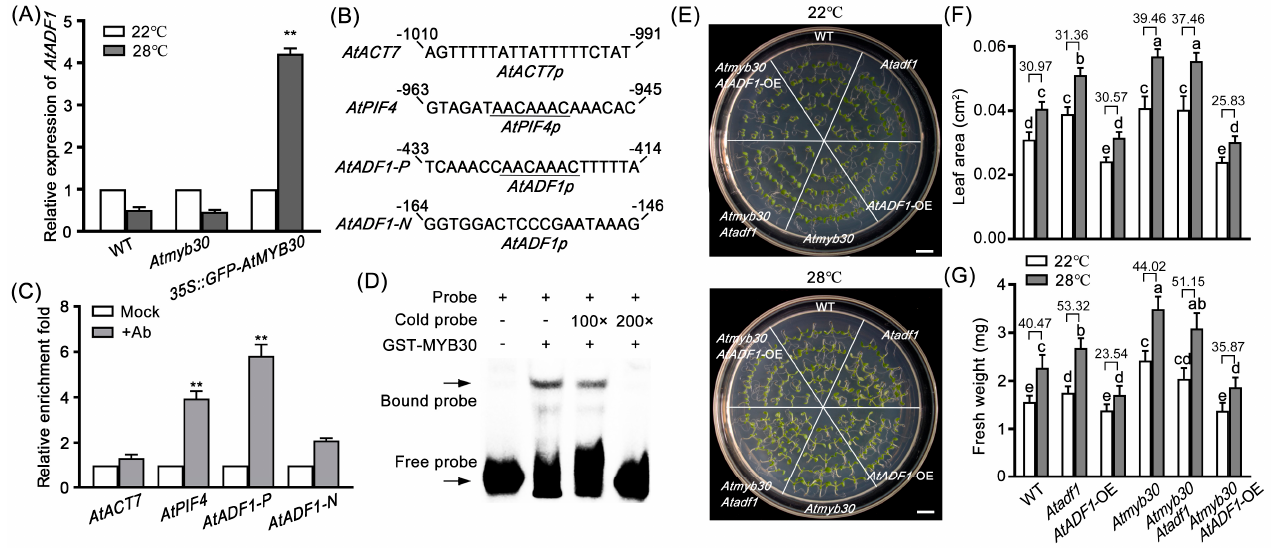
Figure 3. AtMYB30 directly binds to the AtADF1 promoter and positively regulates the expression of AtADF1 under high temperature. ( A ) The relative expression of AtADF1 in 3 − day − old WT, Atmyb30, and AtMYB30 OE seedlings treated with 28 ◦ C for 4 d was determined by RT-qPCR. Data show mean values ± SD from three independent replicates (Student’s t -test, ** p < 0.05). ( B ) MYB − binding site AACAAAC in the AtADF1 promoter. ( C ) ChIP − qPCR analysis indicates that AtMYB30 is associated with the AtADF1 promoter in vivo. AtADF1 − N and AtACT7 are as negative controls, and AtPIF4 is as a positive control. Data show mean values ± SD from three independent replicates. (Student’s t -test, ** p < 0.01). ( D ) EMSA assay of the interaction between AtMYB30 and AtADF1 promoter. The arrow indicates the bands resulting from GST − MYB30 binding to AtADF1 promoter P. ( E ) The thermal adaptation of WT, Atadf1 , AtADF1 − OE, Atmyb30 , Atmyb30 Atadf1 − 1, and Atmyb30 AtADF1 − OE seedlings was visualized. Three − day − old seedlings of WT, Atadf1 , AtADF1 − OE, Atmyb30 , Atmyb30 Atadf1, and Atmyb30 AtADF1 − OE were transferred into a 28 ◦ C chamber for four days. Scale bar = 1 cm. ( F , G ) Leaf area and fresh weight of WT, Atadf1 , AtADF1 − OE, Atmyb30 , Atmyb30 Atadf1 and Atmyb30 AtADF1 − OE seedlings at normal (22 ◦ C) and high temperature (28 ◦ C). The number in the columns is the percentage increase between normal and high temperature conditions. At least 60 leaves from 30 seedlings were examined for leaf area, and at least 300 seedlings were examined for fresh weight, per genotype and treatment. Values are mean ± SD from three independent replicates. All of the statistical analyses use a one-way ANOVA followed by a Tukey’s post-hoc test. Significant differences were indicated by different lowercase letters.